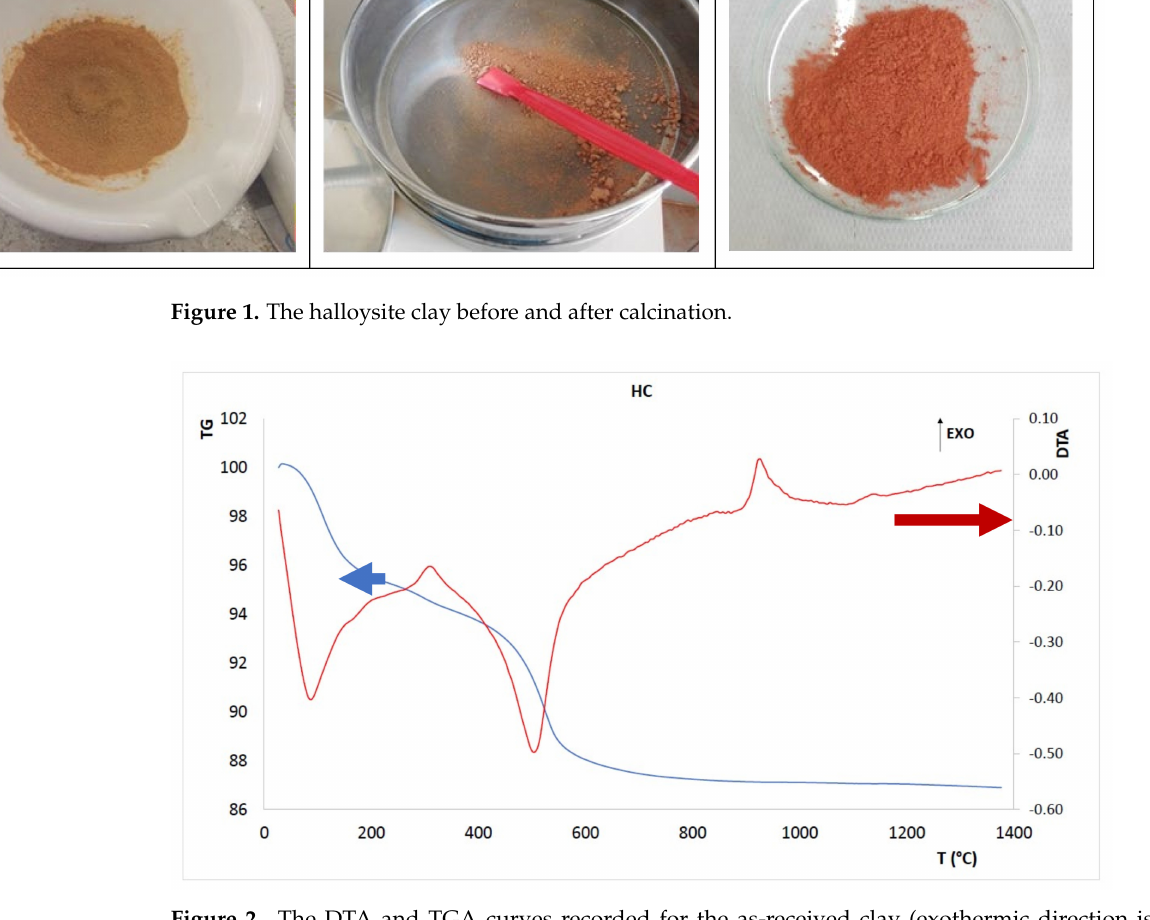
Figure 2. The DTA and TGA curves recorded for the as-received clay (exothermic direction is